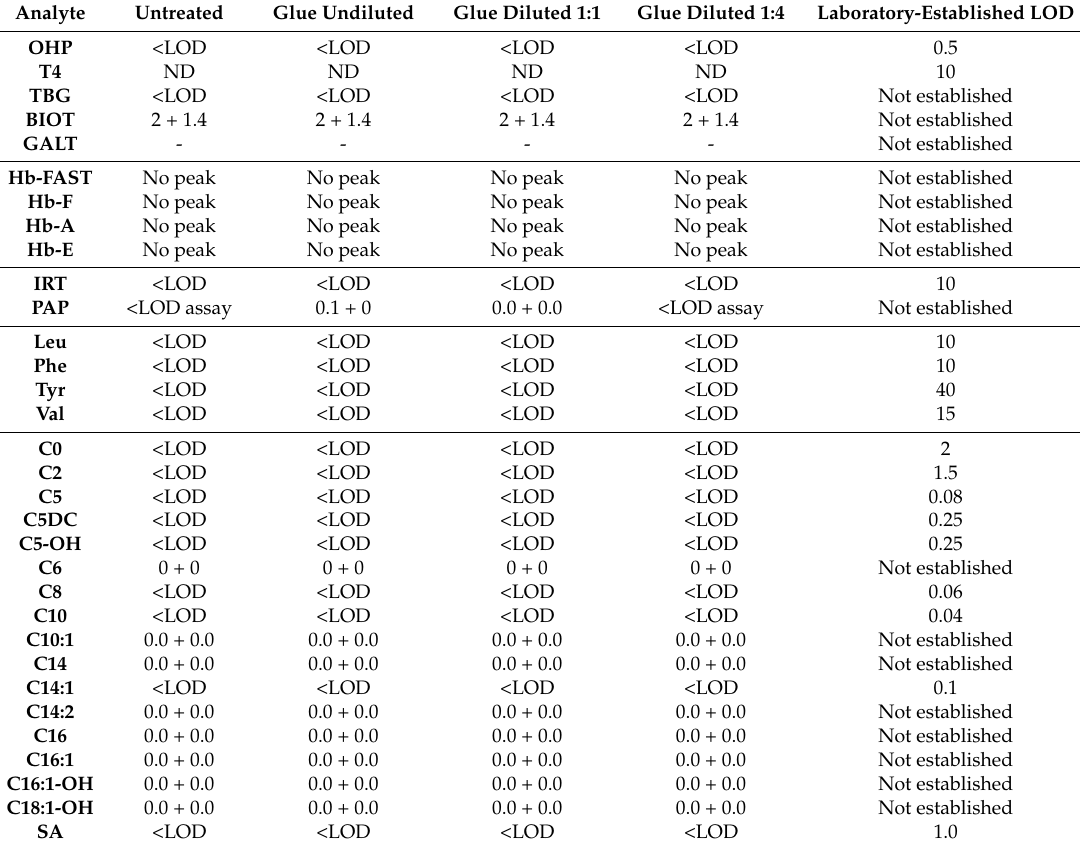
Table 3. Concentrations of analytes in untreated filter paper (no DBSs) and filter paper treated with glue (no DBSs) †